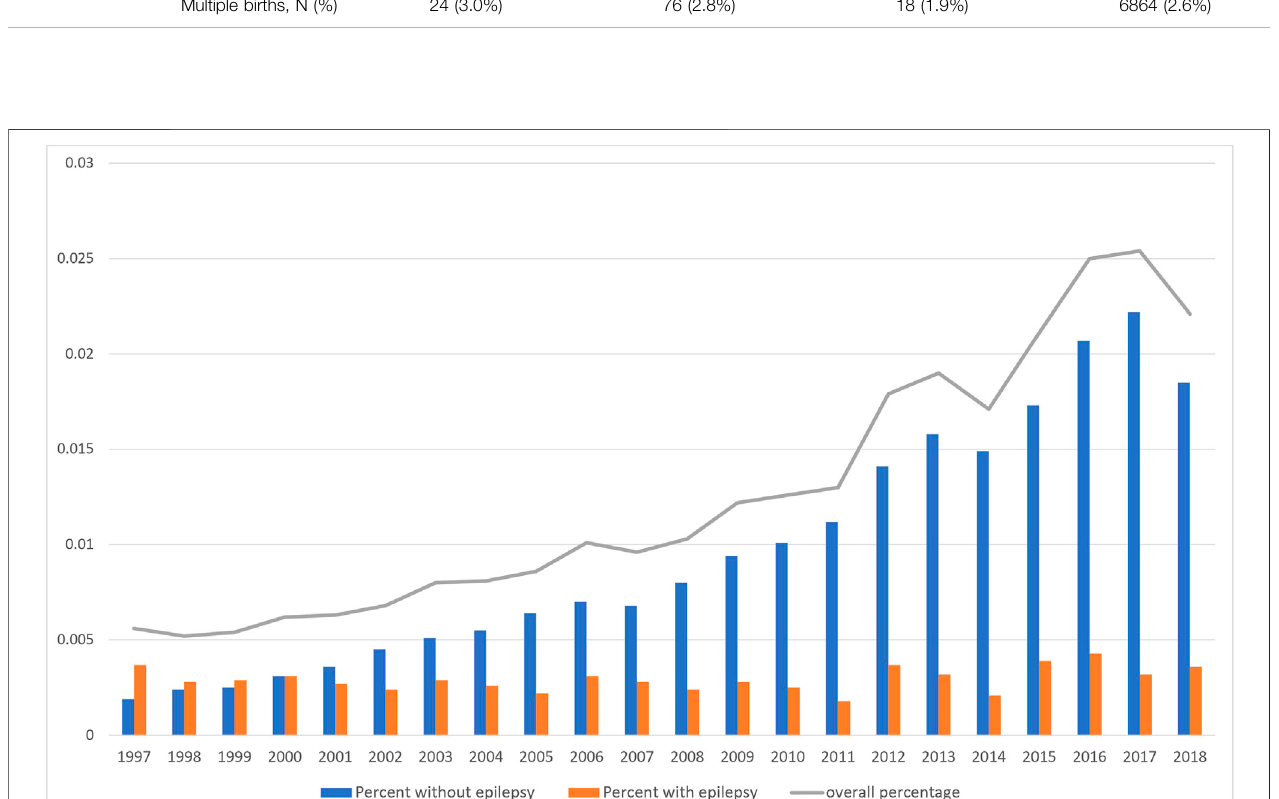
Frontiers in Pharmacology |